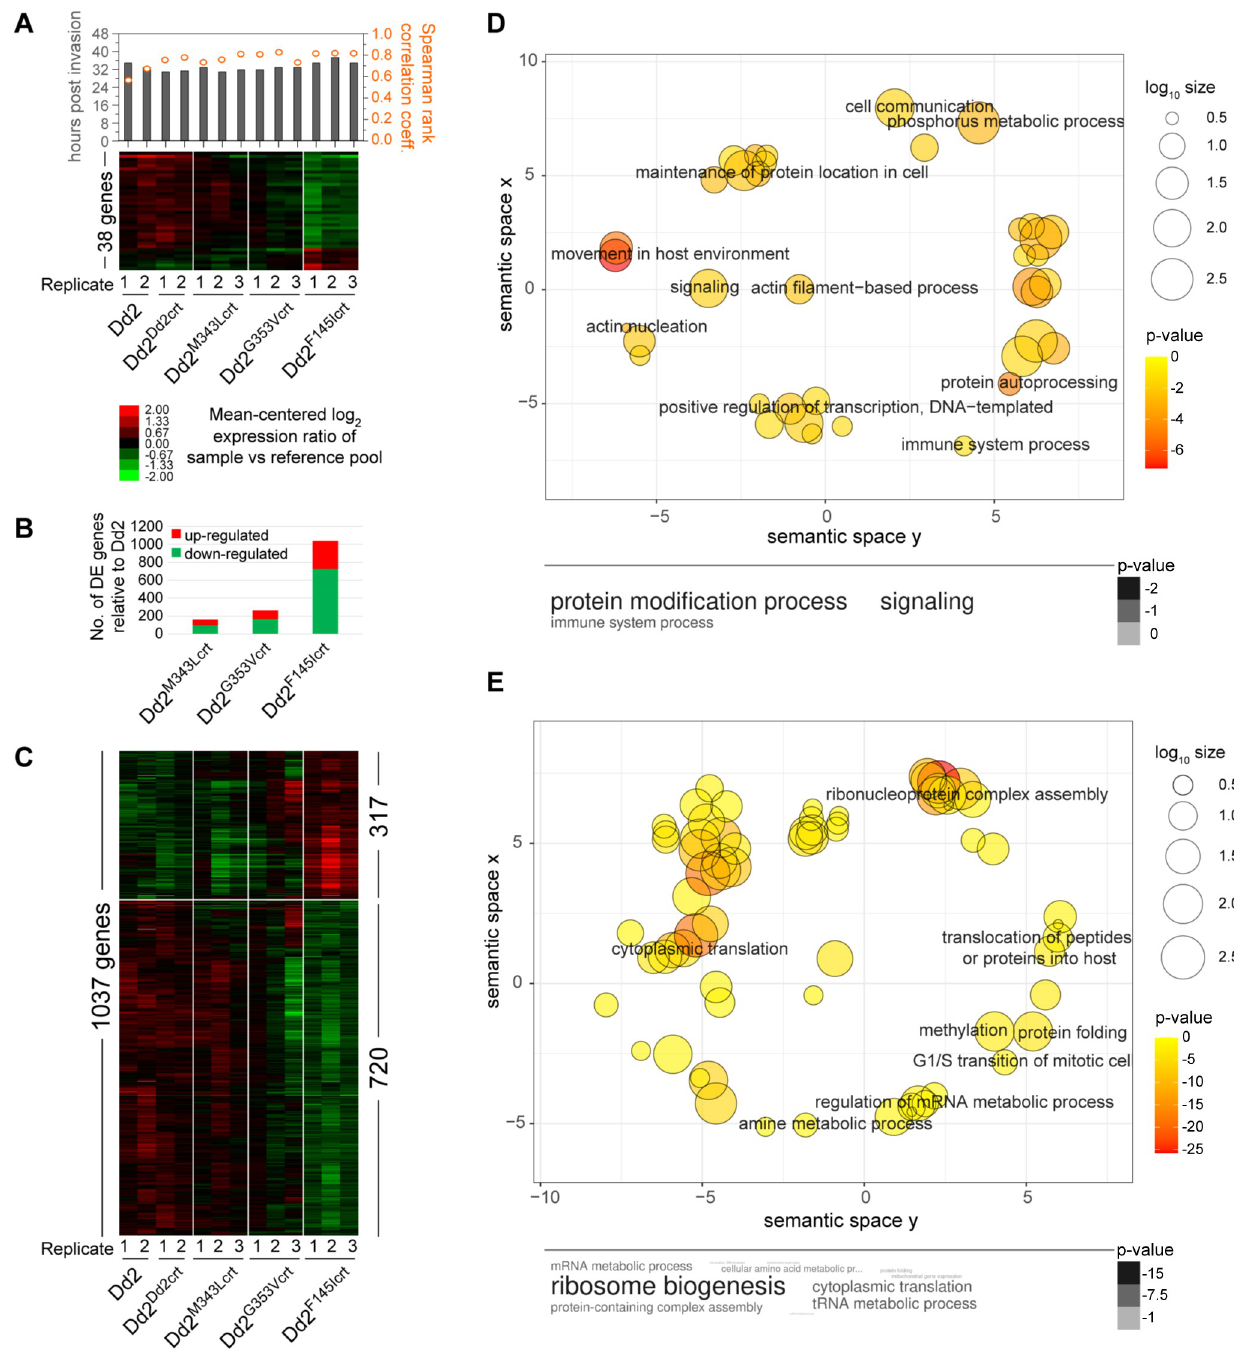
Fig 5. Differential gene expression in PPQ-resistant and PPQ-sensitive PfCRT variants. (A) Mean-centered hierarchically clustered heat map of 38 genes that exhibit differential expression between the four isogenic Dd2 parasites (N = 3–4; one-way ANOVA with permutation p < 0.05). Bars and scatter points, shown above, depict the mapped parasite stage (in hr post-invasion) and the Spearman rank correlation coefficient of each sample, as determined against the 48 hr Dd2 reference transcriptome, respectively. ( B ) Total number of differentially expressed genes for each mutant line relative to the aggregated group of Dd2 Dd2crt and Dd2 parasites (N = 3–4; Student t-tests with permutation p < 0.05) . (C) Mean-centered hierarchically clustered heat map analysis of 1037 genes that exhibit differential expression between the Dd2 F145Icrt and the aggregated Dd2 parasites (N = 3–4; Student t-tests with permutation p < 0.05). (D, E) Significantly enriched pathways in the (D) 317 up-regulated and (E) 720 down-regulated genes observed in the Dd2 F145Icrt line relative to the aggregated Dd2 parasites ( p < 0.05). Pathways were identified using Gene Ontology (GO) enrichment of computed and curated biological processes and visualized by REVIGO to obtain representative pathways. The colors indicate the p value of each GO term and size indicates the frequency of the GO term in the P . falciparum database. Listed p values are to the power of 10.